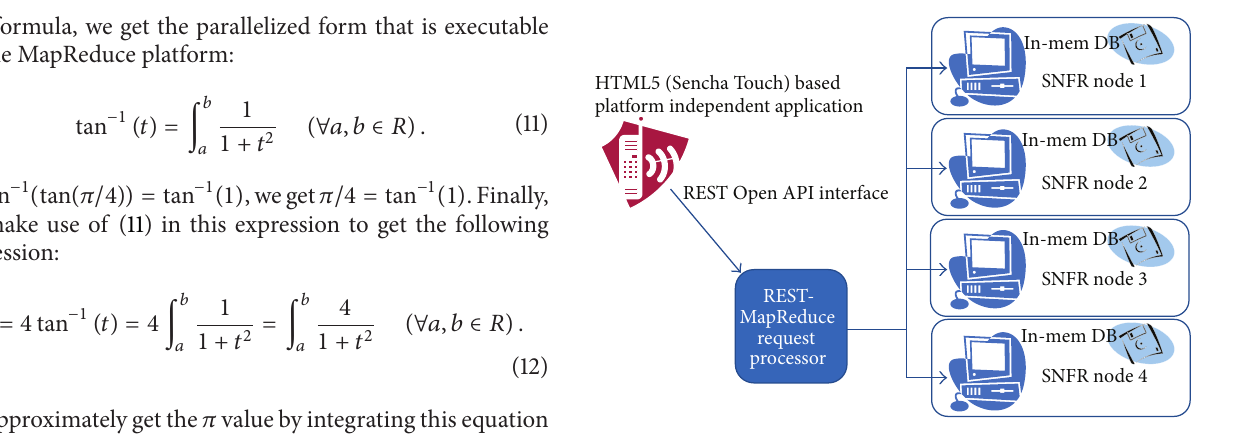
Figure 3: System integration and interactions between the compo-